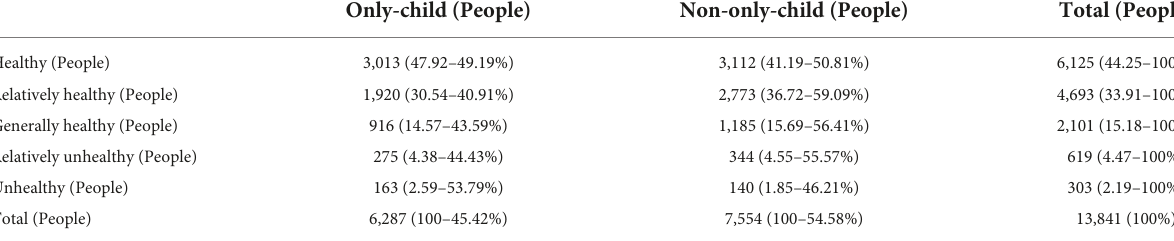
TABLE 3 Mental health status of adolescents from families with multiple children and families with only one child.